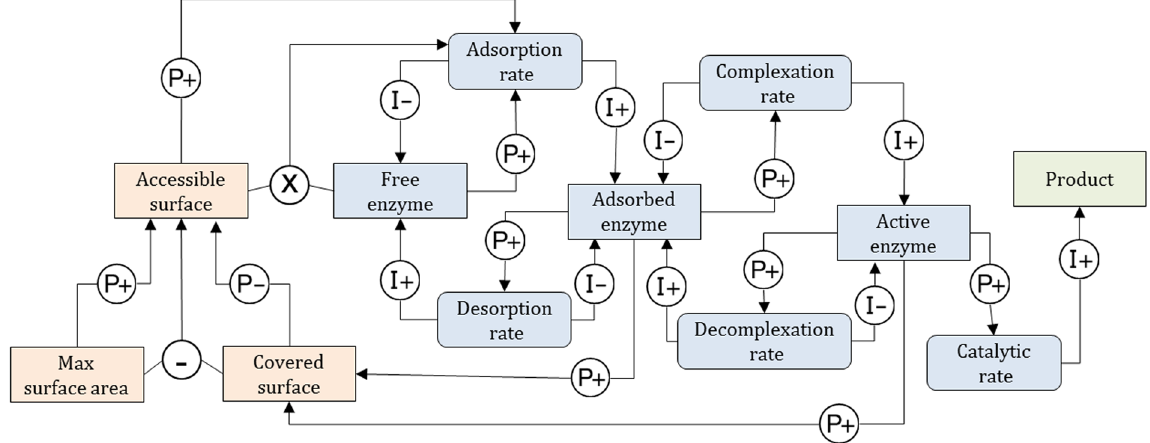
Figure 8. Qualitative Reasoning Model M1 for surface limitation. Square boxes represent concentrations . Rounded boxes represent rates . Causal linkages and are labelled I + / − (Influences) and P + / − (Proportionalities). Influences relate rates to concentrations. Proportionalities propagate information between concentrations, and from concentrations to rates. Algebraic relations can be used in Garp3 through qualitative algebra. Operators are represented by ⊕ , ⊖ and ⊗ . The mapping with the numerical model (1) and (2) is given in Table 5. Orange denotes substrate-related quantities, blue-grey is used for enzyme related quantities, and green denotes product related quantities.